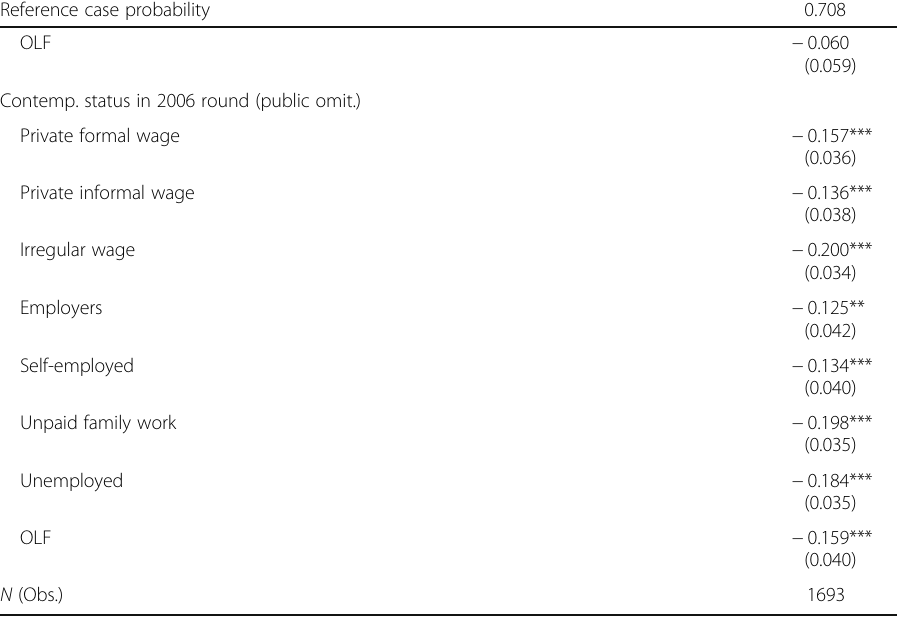
Table 4 Probit model marginal effects for the probability of alignment of reporting a specific type of transition from 1998 to 2006, as calculated using contemporaneous 1998 and 2006 panel data and as calculated using 2012 retrospective data by sex, individuals observed in 1998, 2006, and 2012, aged 20 – 44 in 1998